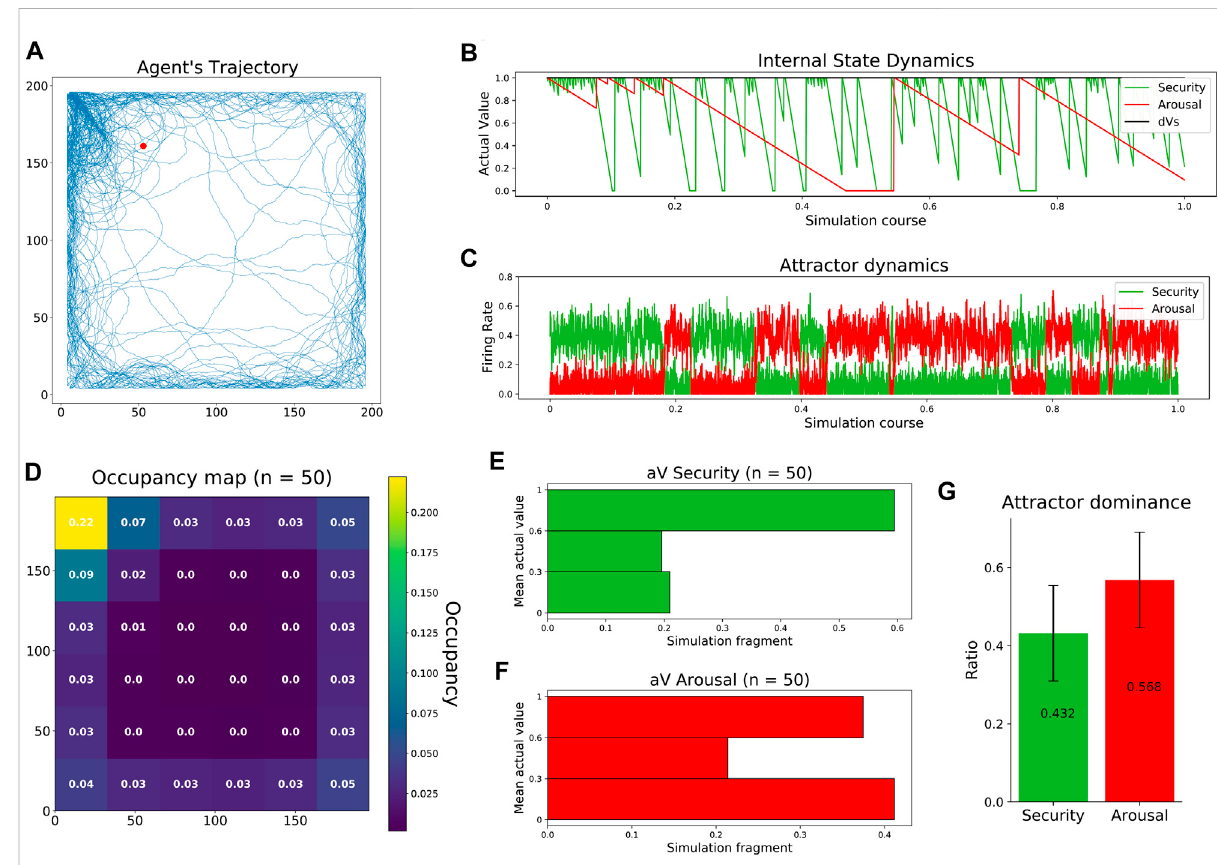
FIGURE 3 Replication of rodent behavior in an open fi eld test. (A) Agent ’ s trajectory tracked along a completeexperiment. The red dot represents starting location, randomized across experiments. (B) Agent ’ s internal state dynamics during a complete experiment (same as a). (C) Firing rates of the excitatory populations con fi guring the neural mass allostatic model during a complete experiment (same as a). (D) Occupancy map across 50 experiments with normalized values. (E) Distribution of security states across 50 experiments. (F) Distribution of arousal states across 50 experiments. (G) Mean attractor dominance across 50